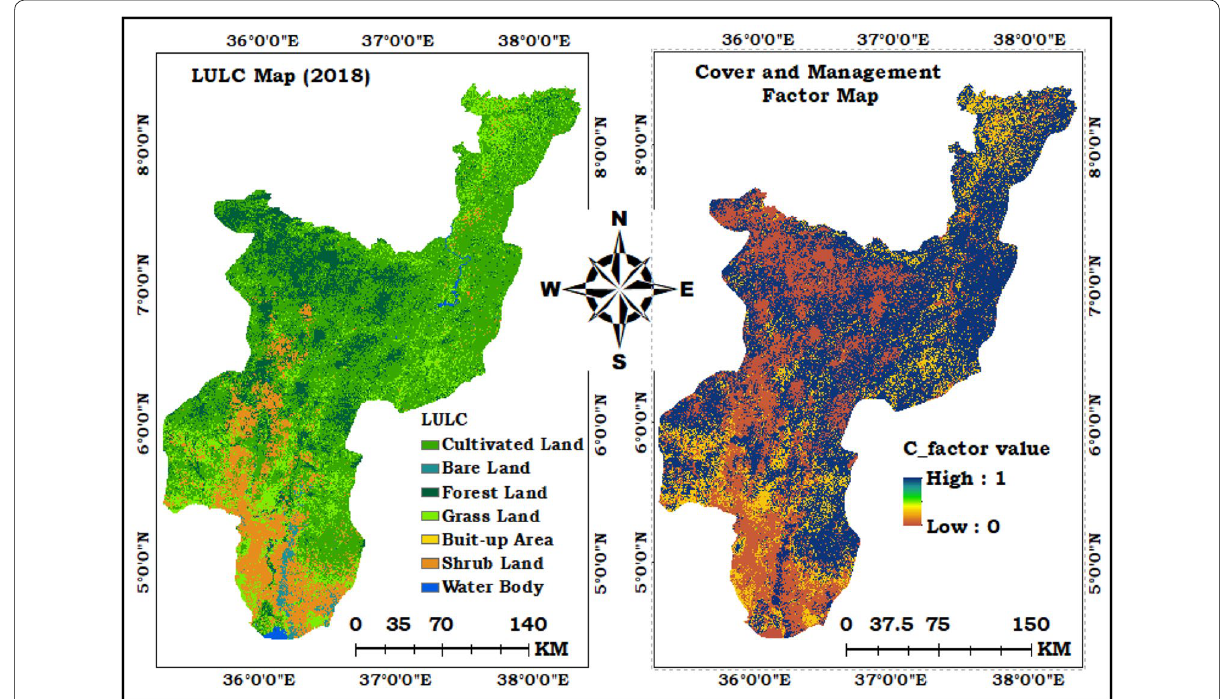
Fig. 6 C factor value (B) map produced from the LULC